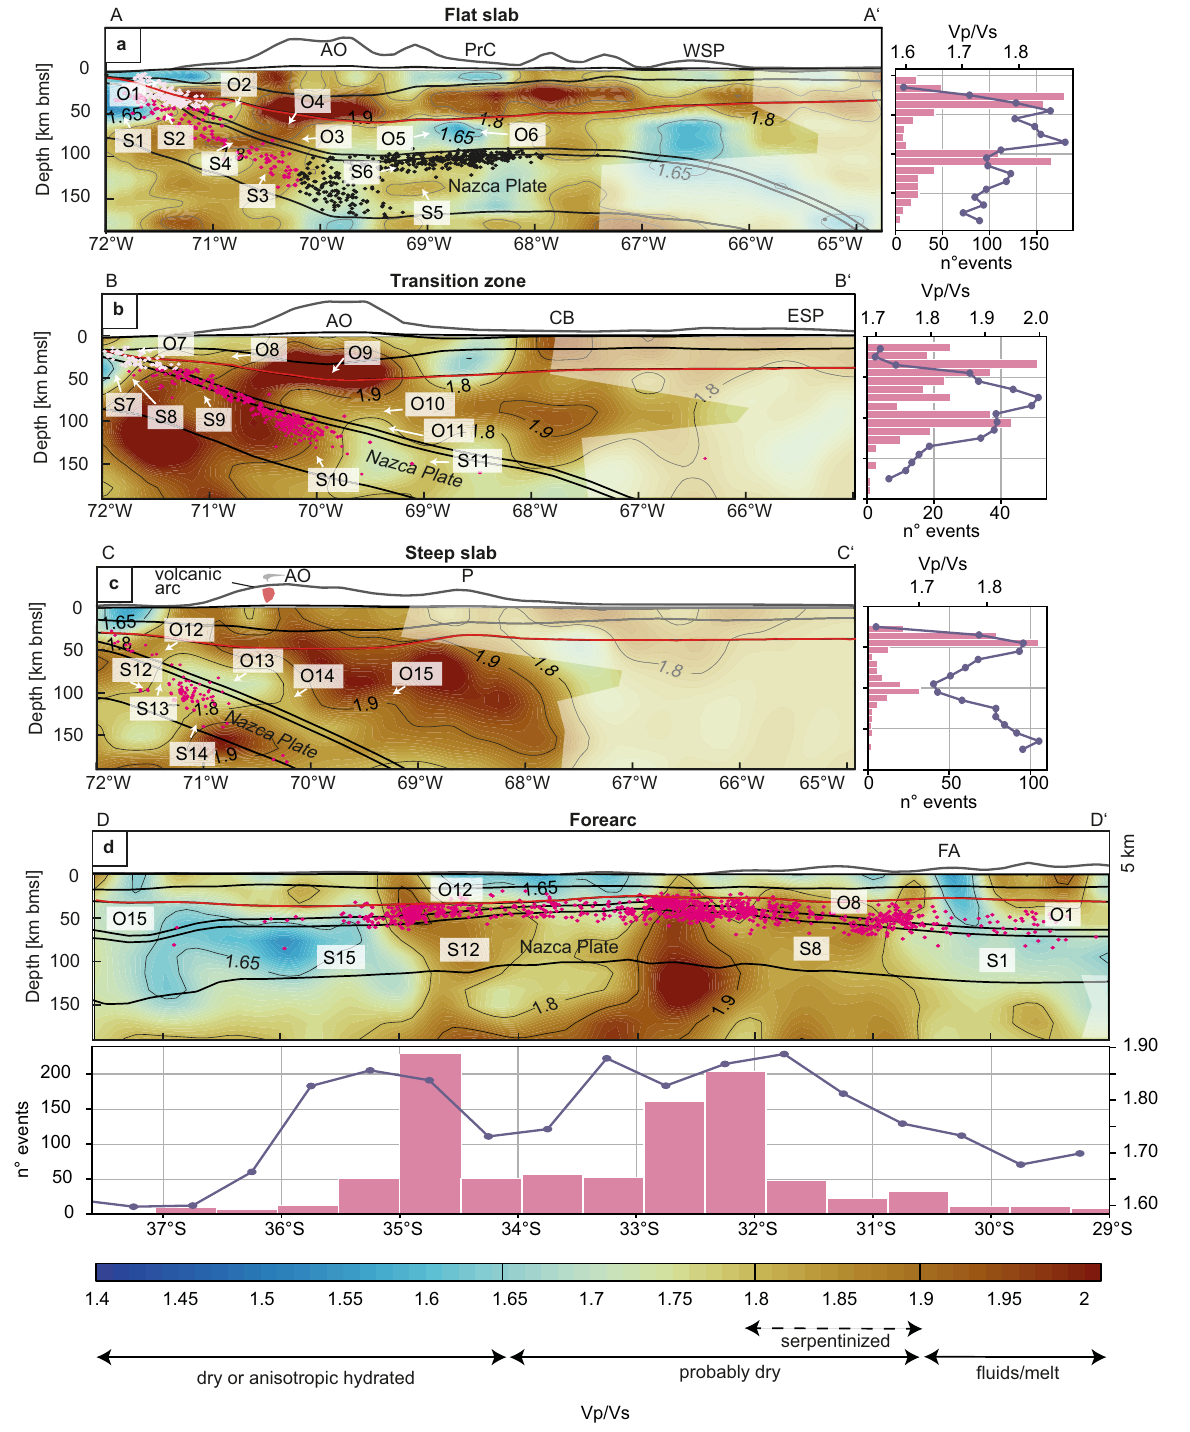
Fig. 2 Vp/Vs ratio of the southern Central Andes. a – d Vp/Vs ratio along cross-sections A – D (see Figs. 1 or 3 for pro fi le locations). Areas with poor resolution are masked with semi-transparent white shading. Dots show the location of hypocentres of slab seismicity 21 within 5 km distance from each pro fi le. Pale pink dots denote seismicity due to brittle stick-slip assisted by dehydration, magenta dots mark dehydration-related seismicity, while black dots show events attributed to fl exure-assisted seismicity. The interfaces of the lithospheric model units are marked by black lines, except for the Moho discontinuity, which is shown by red lines. On top of each pro fi le, topography of the upper plate is displayed with a vertical exaggeration of 10:1. Right panels in a – c and bottom panel in d show the histogram of slab seismicity and the average Vp/Vs within the slab as a function of depth and latitude,